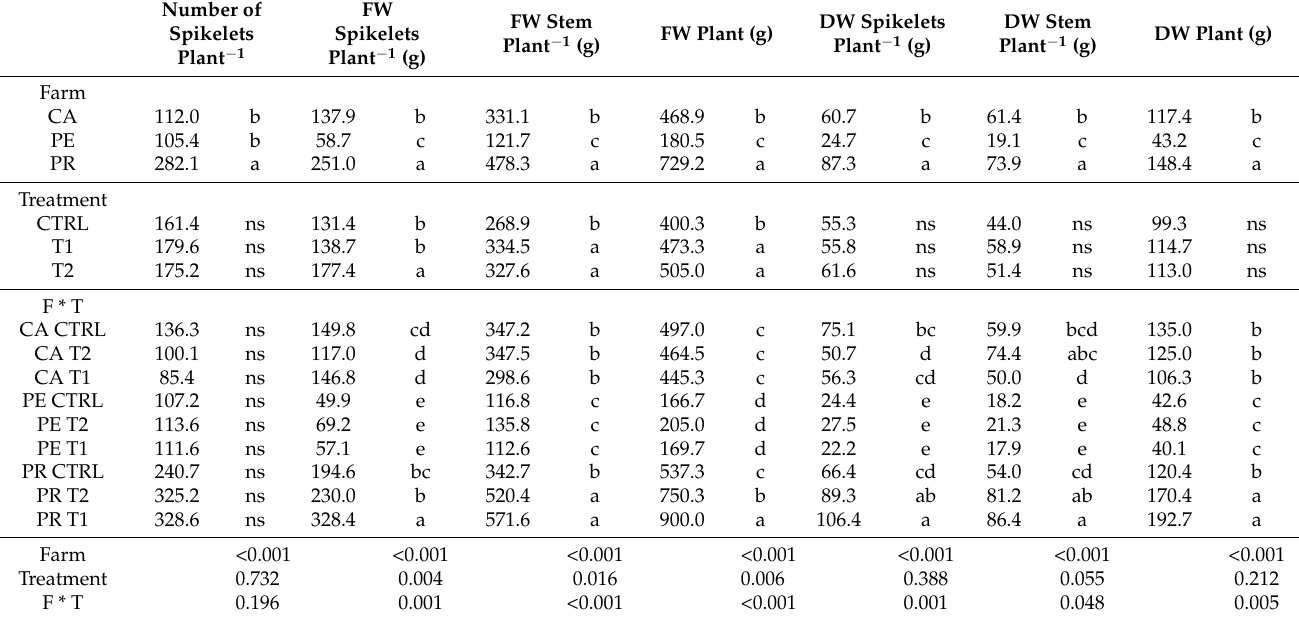
Table 1. Result of the ANOVA test performed on the morphological parameters from 2019/2020. a–e means followed by different letters are statistically significant at p < 0.05; ns, not significant. FW, fresh weight; DW dry weight; F * T, farm * treatment interaction. CA, Campazzo; PE, Pedroni; PR, Preci; CTRL, control with foliar application of tap water; T1, foliar application of FITOSTIM; T2, foliar application of T2.